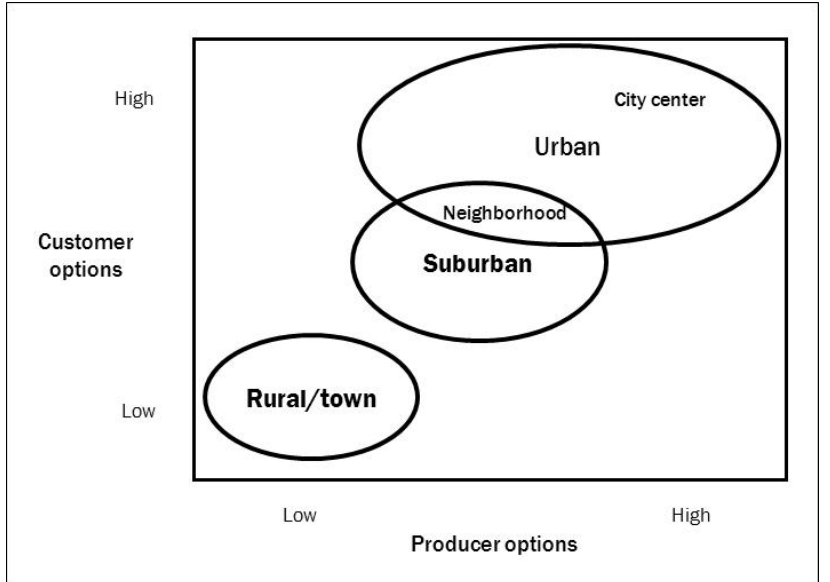
Figure 1. Typology of Farmers